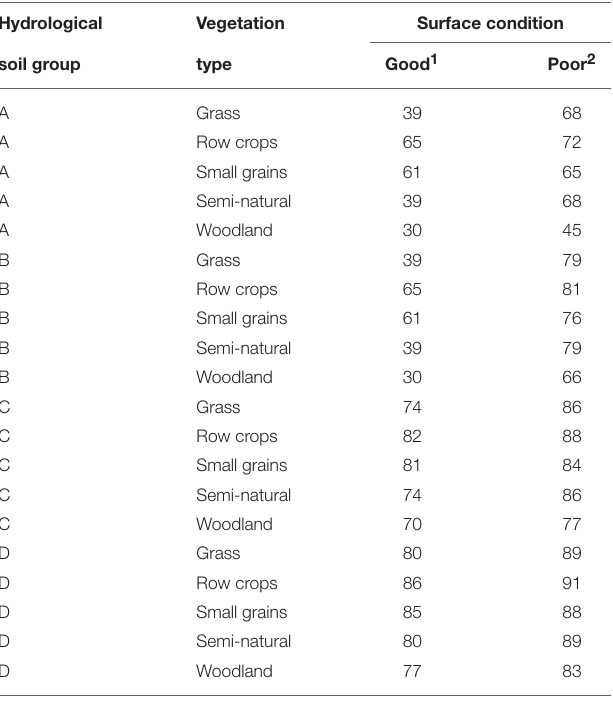
TABLE 4 | Curve Numbers (CN) for surface runoff generation based on Hess et al. (2010). Hydrological